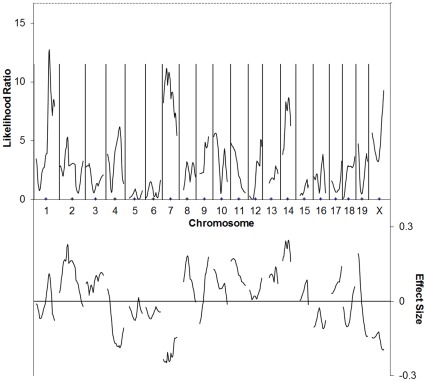
C57BL/6J×129P1/ReJ F2 cross simple interval mapping.Whole genome simple interval map. Top: likelihood ratio statistic or likelihood of a region being linked to bFGF-induced corneal neovascularization. Dashed line indicates P = 0.05 as determined by bootstrapping. Bottom: predicted additive effect of a region on bFGF-induced corneal neovascularization.